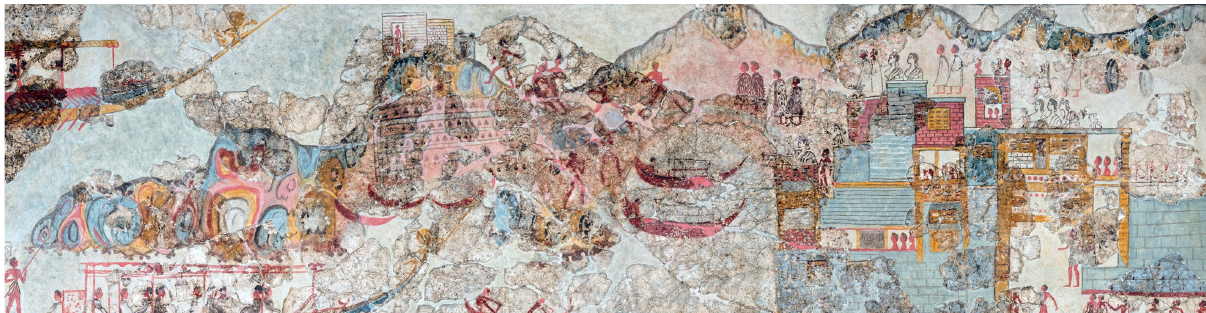
Figure 15: The miniature Flotilla fresco had been found in Westhouse room 5. It depicts a so-called ” departure town ” in its left part and and the so-called ” arrival town ” in its right part (shown here). Between the two towns 12 ships and boats have been painted. Behind and to the left of the ” arrival town ” several hills are shown. A group of four men dressed in fur coats are walking towards the second hilltop left of the ” arrival town ”, on which three buildings can be seen. Following the hypothesis that this hill corresponds the Kokkino Vouno, then the GPR measurements conducted there are likely to have mapped the prehistoric remains of the buildings shown in this